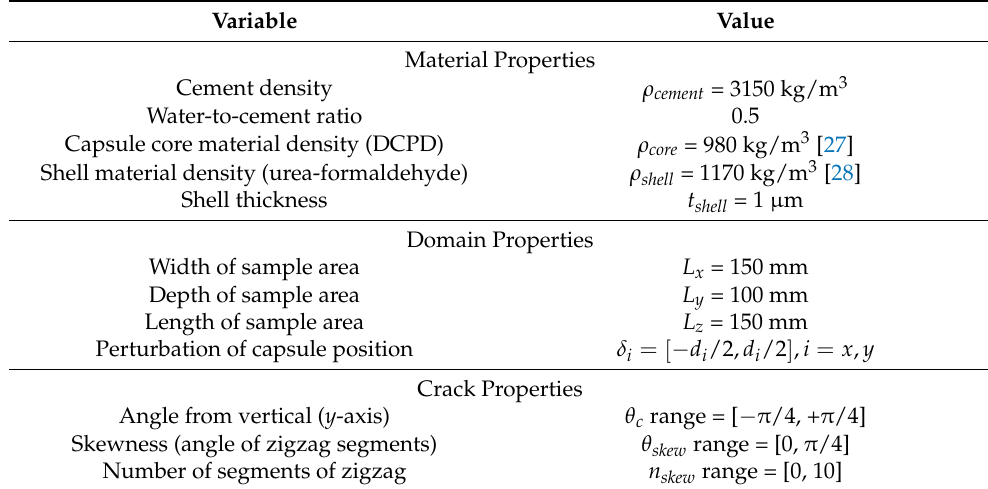
Table 2. Constants and variables considered in the